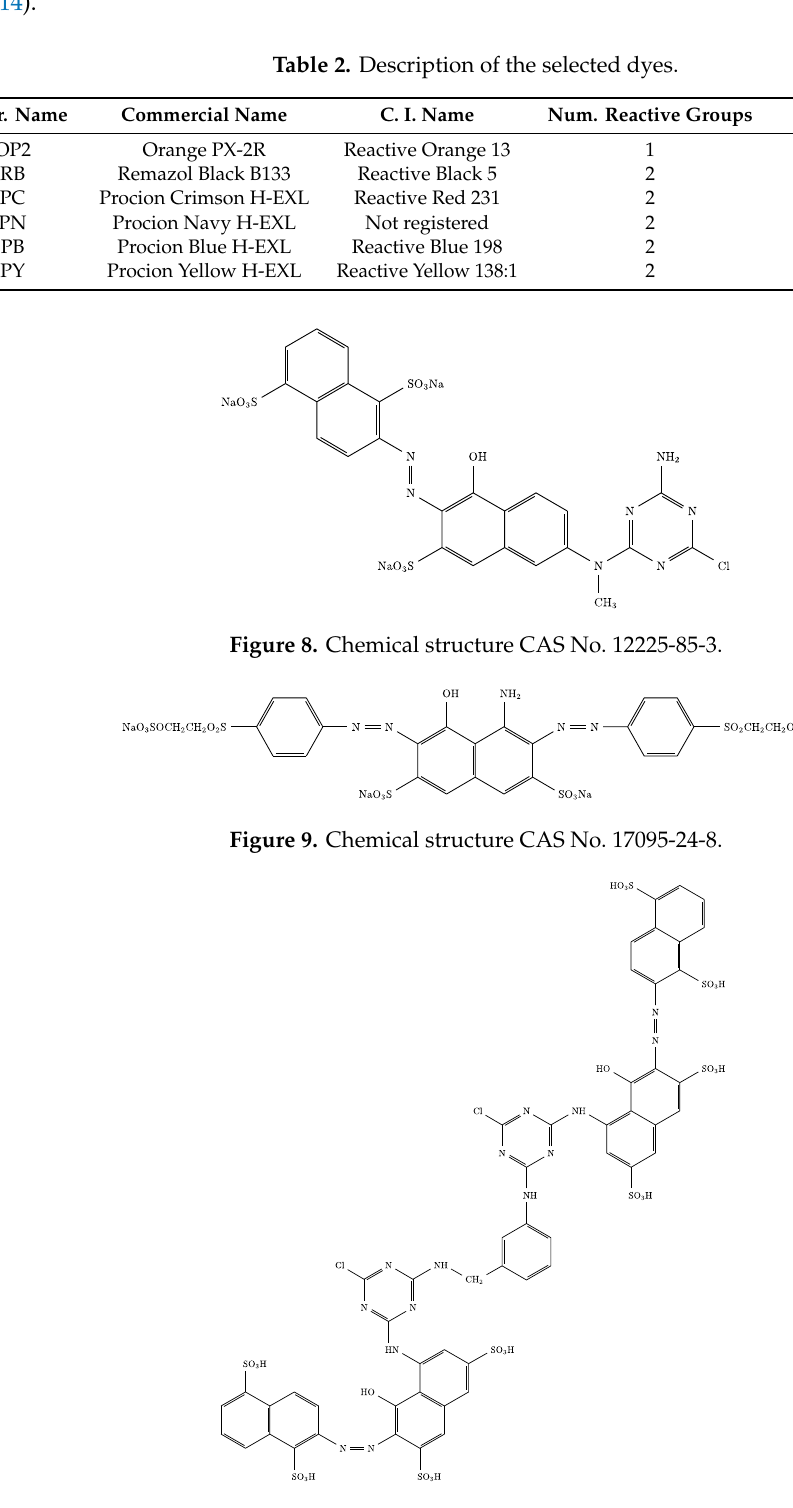
Figure 10. Chemical structure CAS No. 186554-26-7.